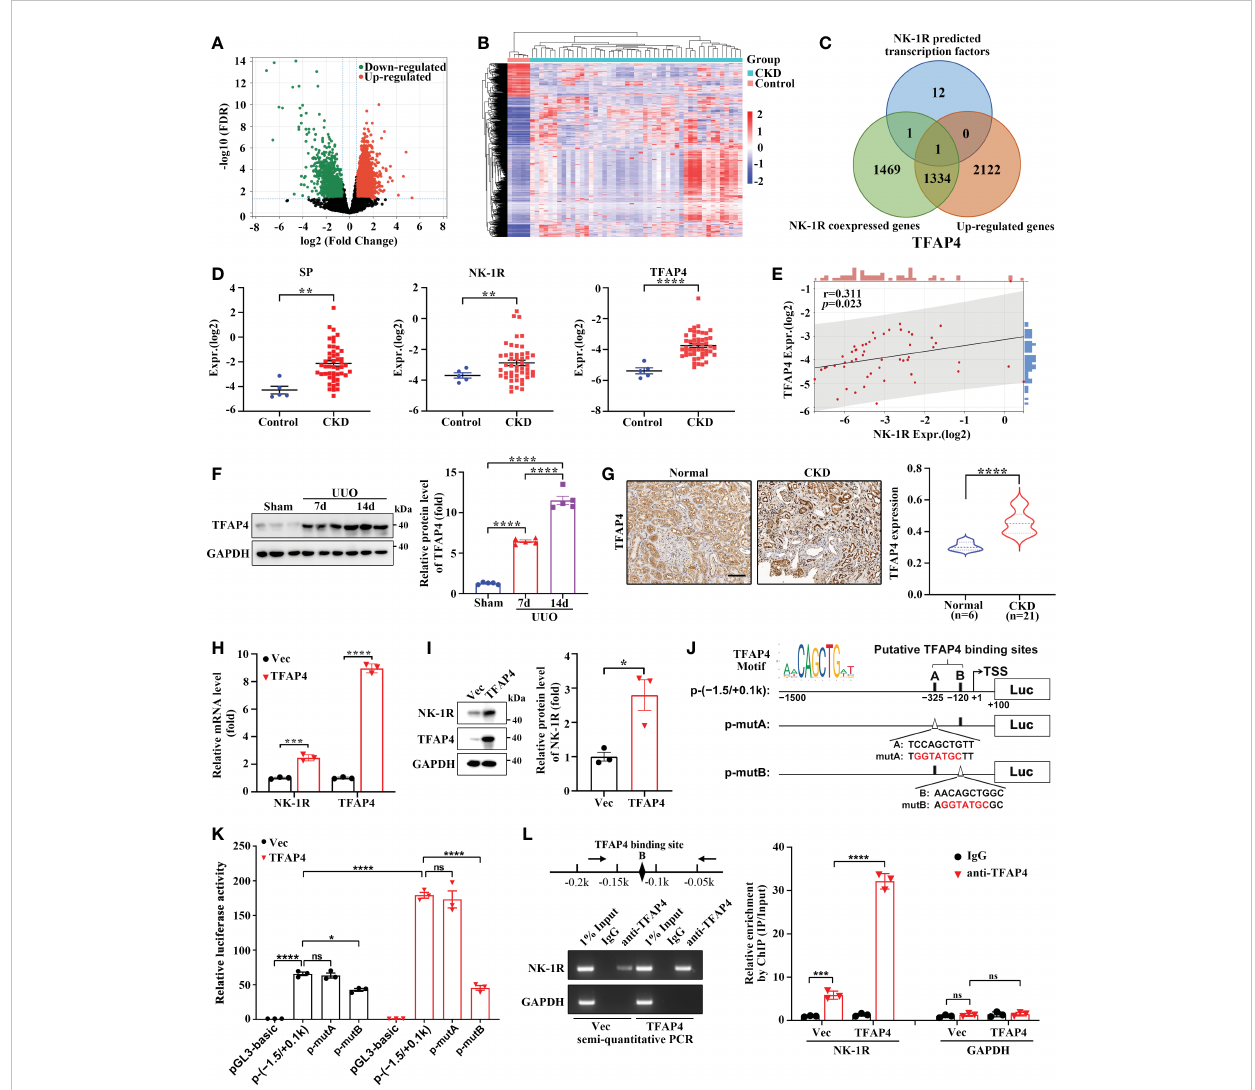
FIGURE 6 TFAP4 is dysregulated in fi brotic kidneys and transcriptionally activates NK-1R expression. (A, B) The volcano plot (A) and heatmap (B) of DEGs between CKD and non-CKD patients from GSE66494 with the threshold of FDR < 0.05 and |log2 (Fold Change)| > = 1. (C) Venn diagram of ConTra v3-predicted NK-1R transcription factors overlapping NK-1R co-expressed genes and up-regulated genes in GSE66494. (D) The mRNA levels of renal NK-1R, SP, and TFAP4 increased in CKD patients based on GSE66494. (E) Correlation between the expression of NK-1R and TFAP4 in GSE66494. (F, G) Western blotting (F) and immunochemistry staining (G) showed the up-regulated expression of renal TFAP4 protein in UUO mice and CKD patients, respectively. (H, I) Real-time quantitative PCR (H) and Western blotting (I) showed that the stable overexpression of TFAP4 increased NK-1R mRNA and protein levels in HK-2 cells. (J, K) Overexpression of TFAP4 enhanced the activity of the NK-1R promoter, whereas the mutation of the potential TFAP4 binding site B but not A reduced its activity. Schematic diagram for fi re fl y luciferase reporter plasmids containing -1.5 to +0.1 k region of NK-1R is shown. Potential TFAP4 binding sites (BS) in the NK-1R promoter are depicted as a close rectangle A/B, and mutant TFAP4 BS are depicted as an open triangle A/B. (L) ChIP assay showed that TFAP4 directly interacted with the NK-1R promoter in vivo . The antibody-precipitated DNA was ampli fi ed by semi-quantitative PCR for 30 cycles (left) and real-time quantitative PCR (right). The promoter of GAPDH was used as a negative control. Data are presented as mean ± SEM. * p < 0.05; ** p < 0.01; *** p < 0.001; **** p < 0.0001; ns, not signi fi